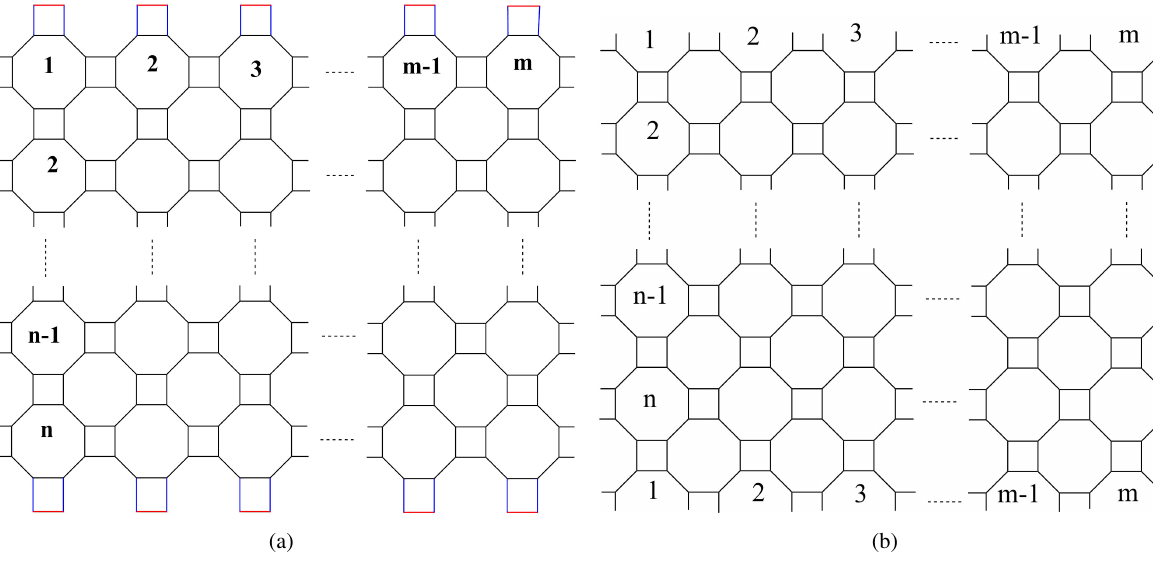
Fig. 4 Two-dimensions of TUC 4 C 8 ( S )[ m , n ] (a) nanotube and (b) nanotorus